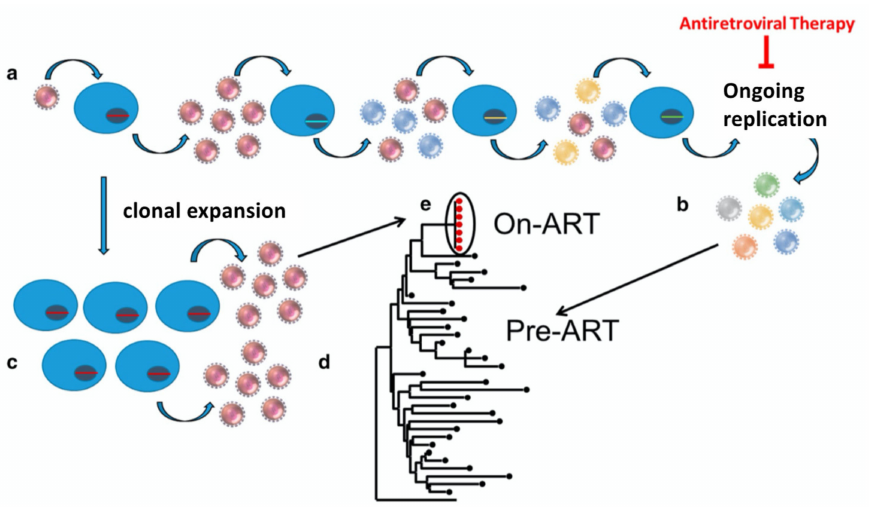
Figure 1. Ongoing HIV replication and clonal expansion. ( a ) In most individuals, HIV infection starts with a single virion (brown) and, during successive cycles of replication, shown left to right, the viruses in the population accumulate mutations, indicated in ( b ) by the multicolored virions, and, as shown in ( e ), a diverse phylogenetic structure. As indicated in ( c ), ART initiation halts ongoing viral replication, leaving a small fraction of infected cells, which, as shown in ( d ), grow into clones, a few of which can release virus with identical genome sequences into the blood. Reprinted from